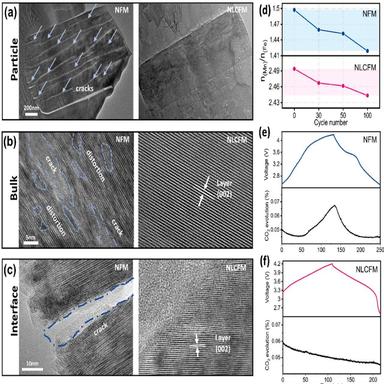
Post-mortem analyses of NFM and NLCFM electrodes. (a) The cross-sectional images of the particles at low magnification. (b–c) The HRTEM images acquired in the bulk and at the interface. (d) The trend in the molar ratio of Mn to Fe within cathode electrodes during cycling. (e–f) CO2 evolution of NFM and NLCFM cathodes upon first cycle.